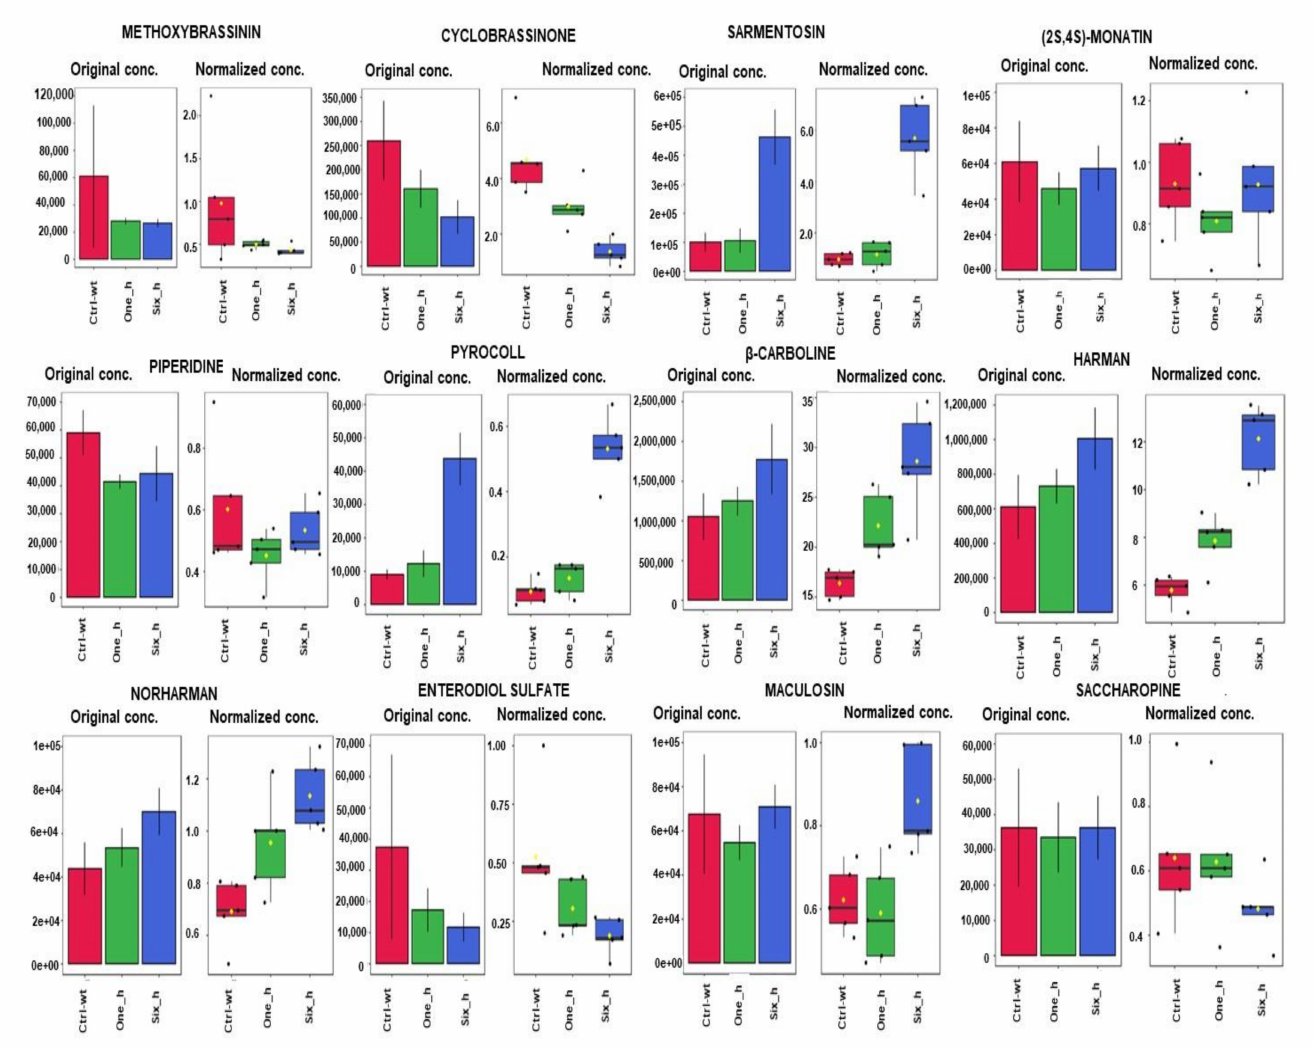
Figure 5. Graphical summary of the effect of carvacrol on changes of the newly identified metabolites in X. perforans in the time-series. Treatments include untreated wild type (ctrl-wt), samples at 1 h after treatment with carvacrol (One_h), and samples at 6 h after treatment with carvacrol (Six_h). Each treatment was replicated four times. A pooled sample from all four replicates for each treatment was included as a fifth replicate. Each bar in the plot represents the average intensities of the combined values of the five replicates in each treatment. The bar plots on the left show the original values. The box and whisker plots on the right summarize the normalized